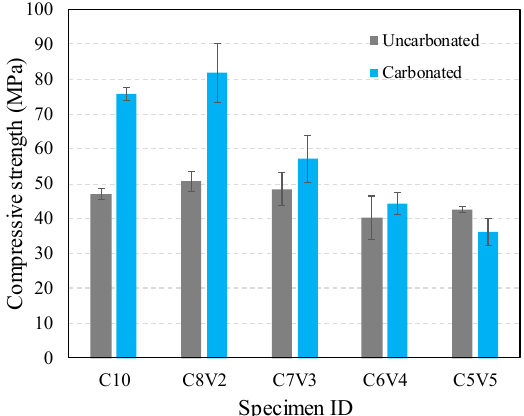
Figure 3. Compressive strength of normally cured and carbonation-cured volcanic ash-blended PC at 28 days.